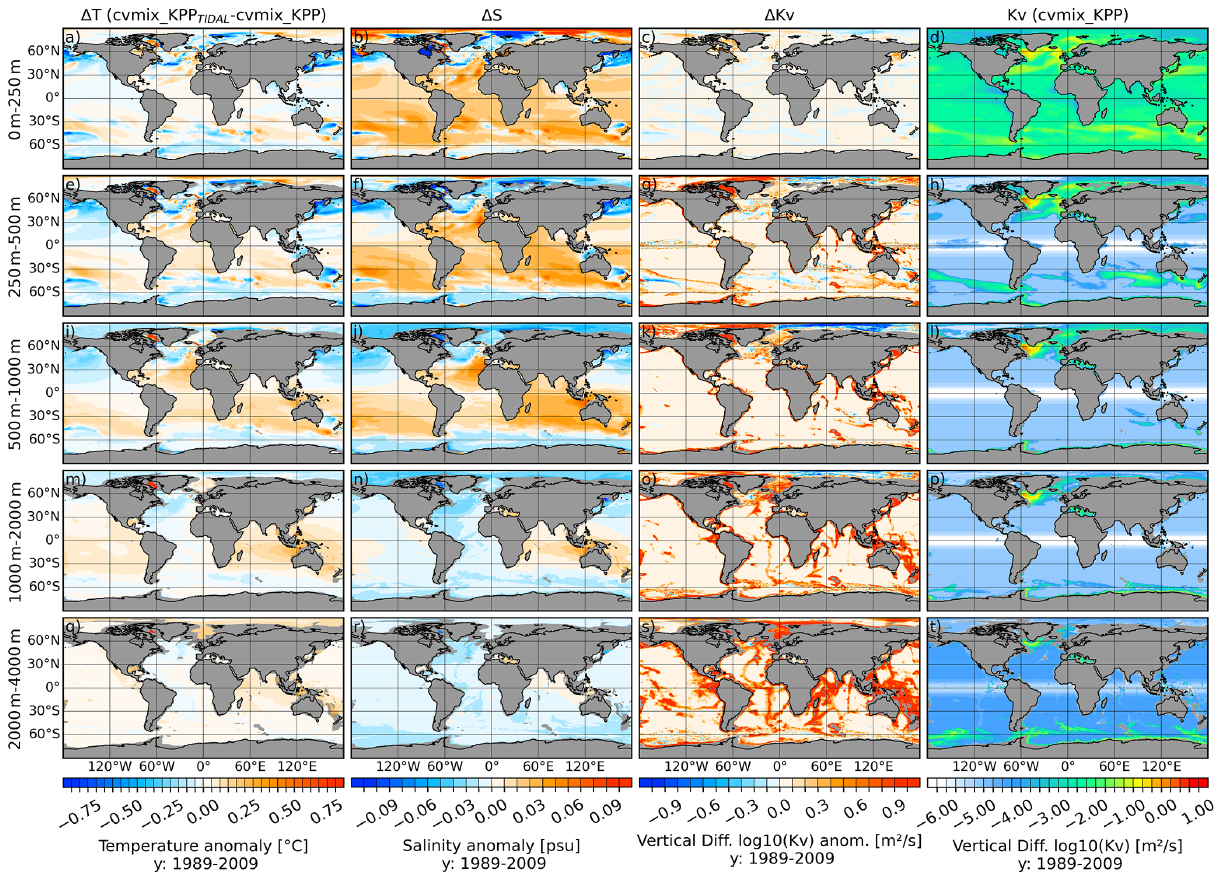
Figure 13. Temperature ( a, e, i, m, q ), salinity ( b, f, j, n, r ) and vertical diffusivity ( c, g, k, o, s ) difference between cvmix_KPP with and without TIDAL mixing of Simmons et al. (2004) and the absolute vertical diffusivity values ( d, h, l, p, t ) for cvmix_KPP without TIDAL mixing averaged for the period 1989 to 2009. The panels show, from top to bottom, the vertically averaged fields for the depth ranges of 0–250, 250–500, 500–1000, 1000–2000 and